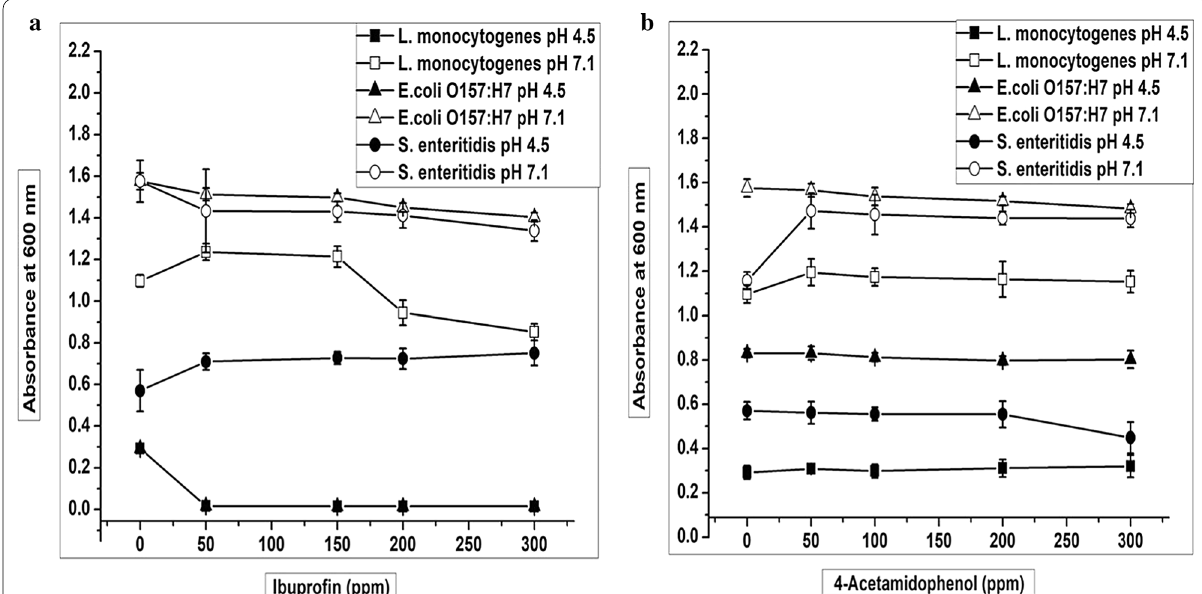
Fig. 7 Influence of pH on bactericidal activity of each antimicrobial against E. coli O157:H7 , S. enteritidis, and Listeria monocytogenes. a Ibuprofen, b 4-Acetamidophenol. Ibuprofin and 4-Acetamidophenol concentrations (0, 5, 10, 15, 20, and 25) ppm were each added to 10-ml tryptone soya broth tubes and then inoculated (50 μl) of an overnight culture of bacterial suspension (O.D 600 1.818). Tubes were incubated at 37 °C for 24 h. Negative = and positive controls were performed. The optical density of each tube was measured using a spectrophotometer. Data shown as a mean of two independent experiments with standard error ( P < 0.05)